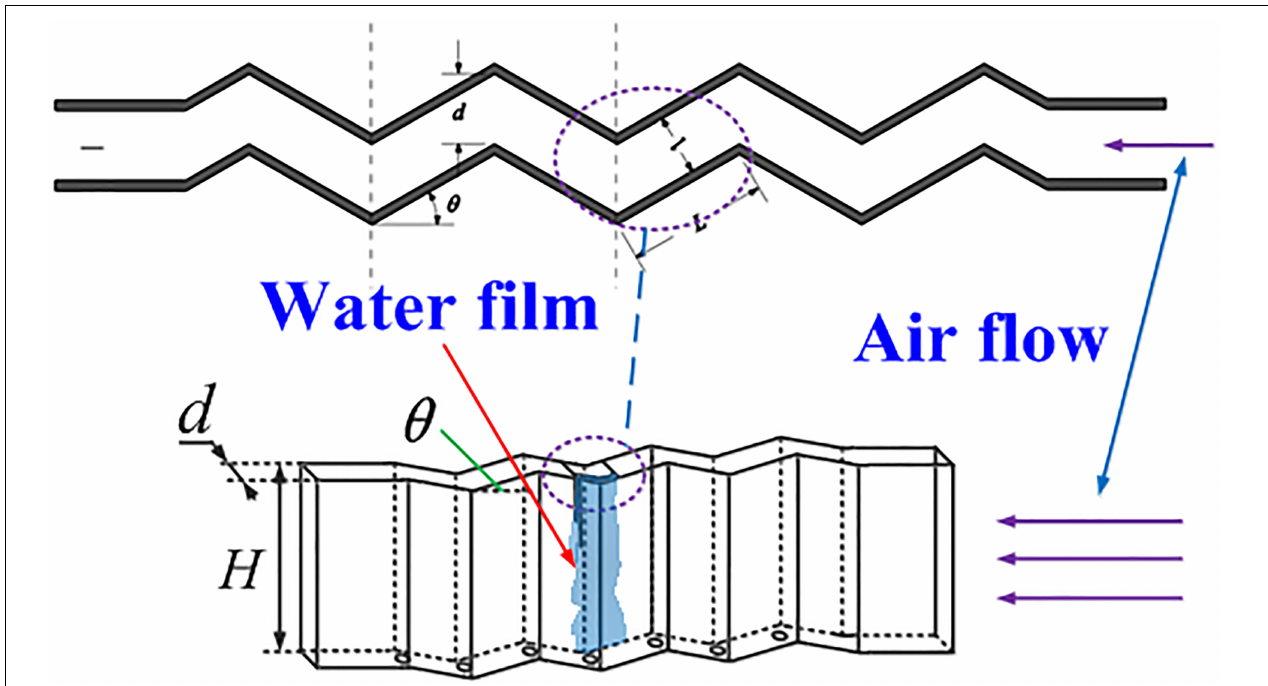
FIGURE 1 | Structure of the corrugated plate dryer and the distribution of different phases in corrugated